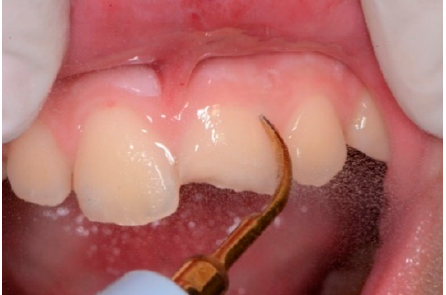
Figure 12. Supragingival ultrasonic scaling with a universal tip using the “soft mode” setting.